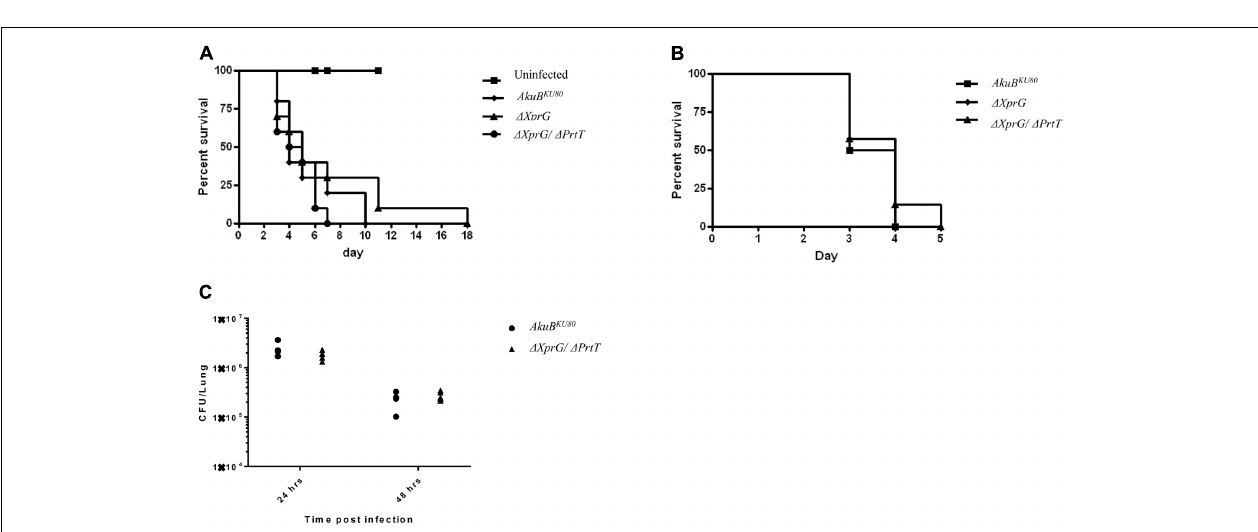
FIGURE 4 | Effect of the deletion of prtT , xprG and xprG / prtT on the secretome of A. fumigatus . Deletion of prtT , xprG and xprG / prtT (A) reduces the secretion not only of proteases but also of glucanases and chitinases participating in cell wall biosynthesis and of numerous allergenic proteins. (B) Venn diagram illustrating the degree of overlap in the secretome datasets of the mutant strains.